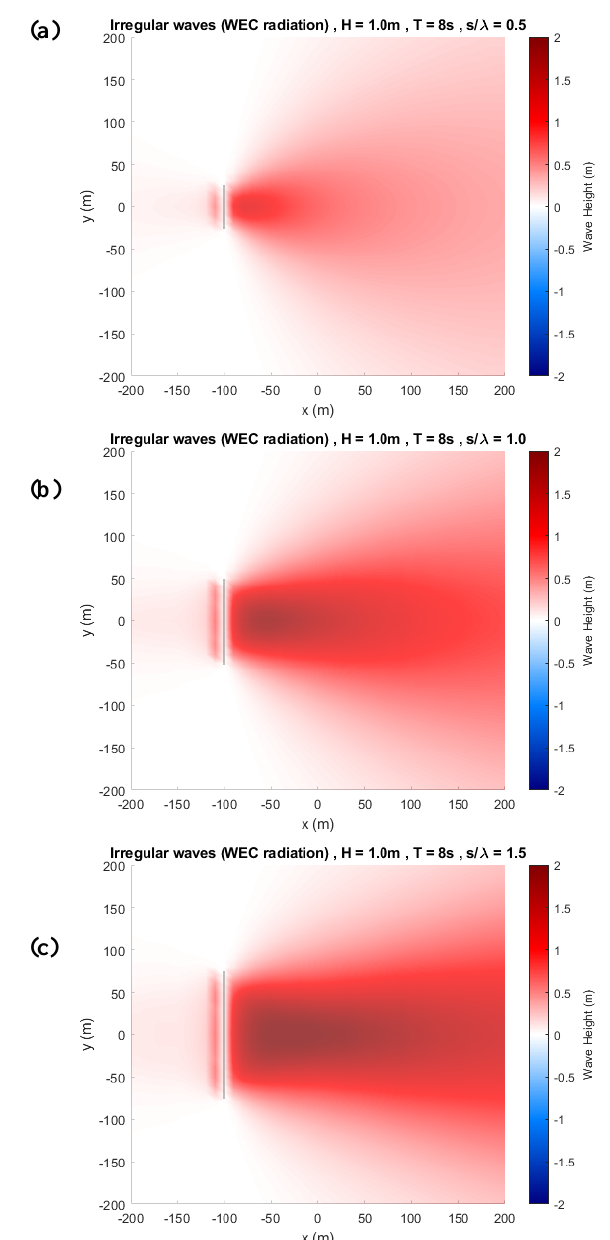
Figure 5: Instantaneous snapshot of the radiated wave field for an Figure 6: The time averaged significant wave height of the radiated wave field assuming an irregular wave condition for different irregular wave for different WEC spans, (a) 𝑠 𝜆⁄ = 0.5 , (b) 𝑠 𝜆⁄ = spans, (a) 𝑠 𝜆 ⁄ = 0.5 , (b) 𝑠 𝜆 ⁄ = 1.0 , and (c) 𝑠 𝜆 ⁄ = 1.0 , and (c) 𝑠 𝜆 ⁄ = 1.5 .